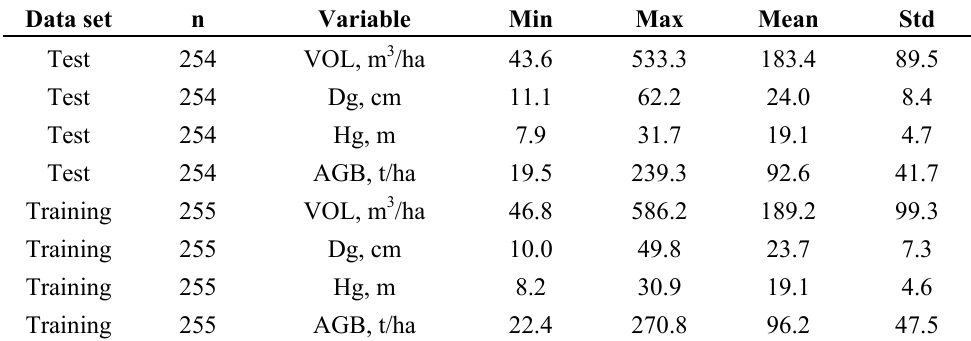
Table 2. Plot-level statistics for field measurements. 254 circular, fixed-radius (r = 10 m). The plots were used as the test set and 255 plots as the training set for